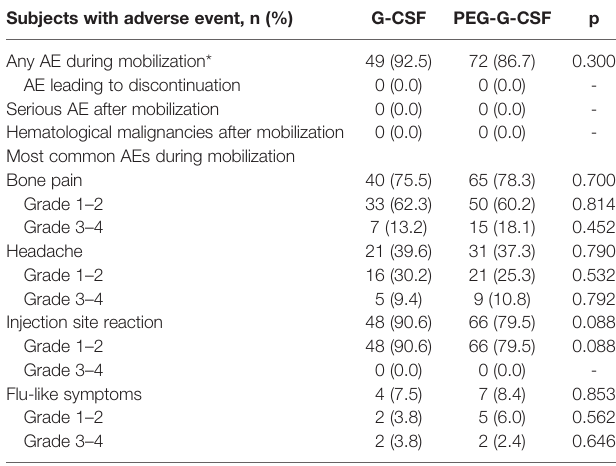
Subjects with adverse event, n